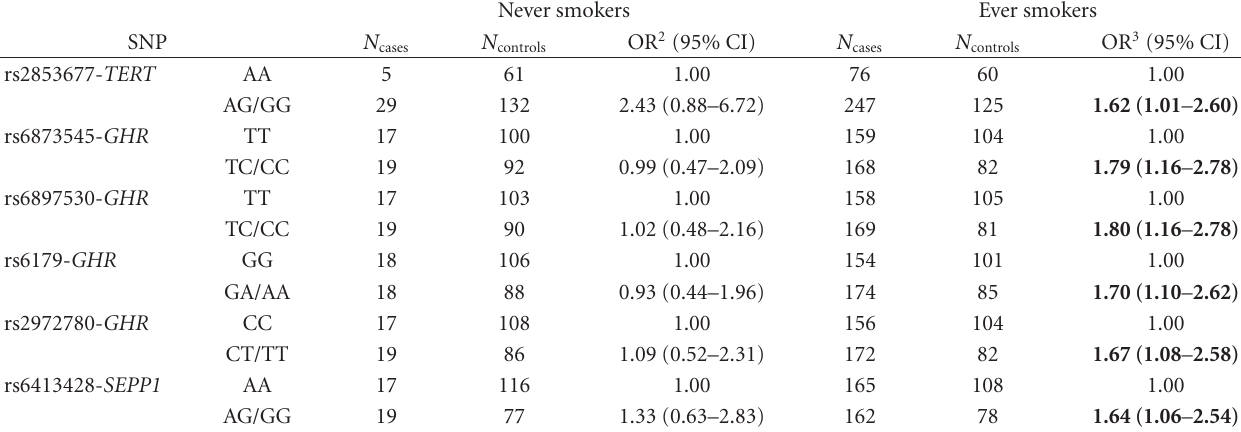
Table 4: Chromosome 5p SNPs and NSCLC Risk by Smoking History (Never/Ever) among Caucasians 1